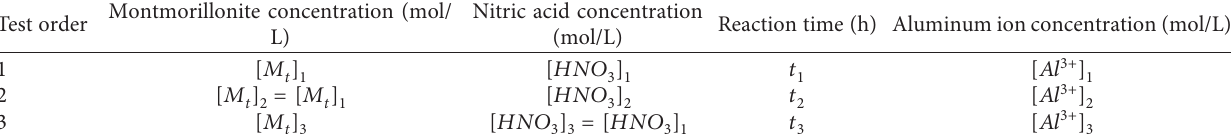
Table 1: Concentration relationship between montmorillonite and HNO